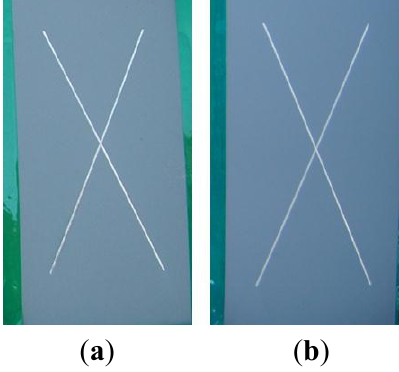
Figure 3. Photos after 12 months of outdoor exposure testing. ( a ) control; ( b ) BAM-PPV.